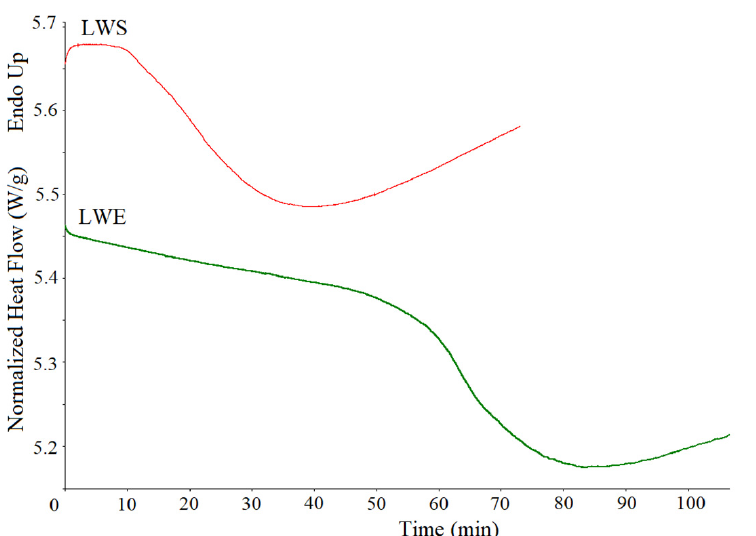
Figure 1. Differential scanning calorimetry (DSC) oxidation induction time (OIT) curves measured for fresh LWS and LWE samples at 120 °C temperature.